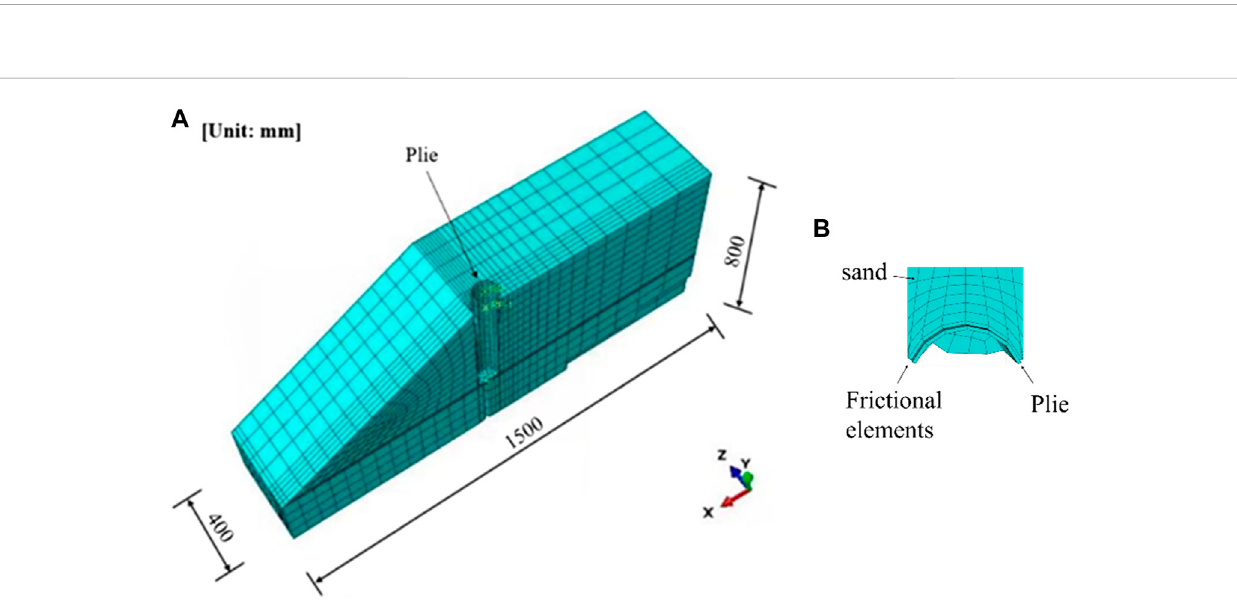
FIGURE 3 Symmetric3D fi niteelementmodelofthesinglepilenearasandyslope: (A) overallmodel; (B) thepile – soilinterfacemodeledbyfrictionalelements.